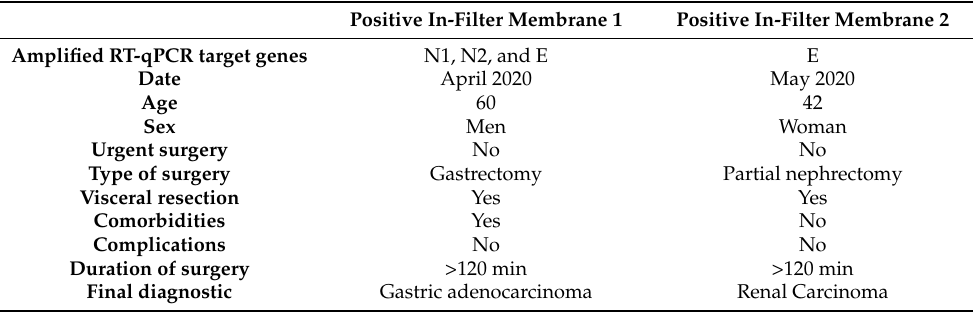
Table 2. Clinicopathological characteristics of the two positive laparoscopic filters.